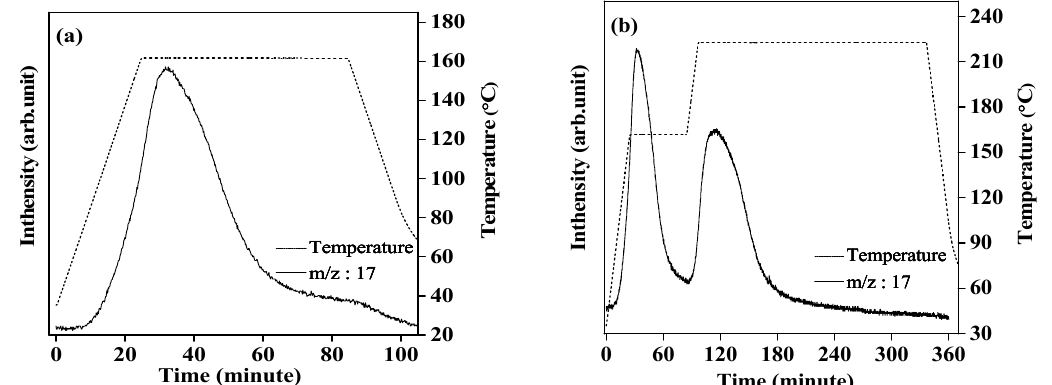
Figure 1. Thermal desorption mass spectroscopy (TD-MS) profile of complex LiK(NH 2 ) 2 under 0.5 MPa H 2 flow condition at 160 °C for 1 h ( a ), and following 220 °C for 4 h ( b ), where the heating rate is 5 °C/min and m/z is 17 for NH 3 .